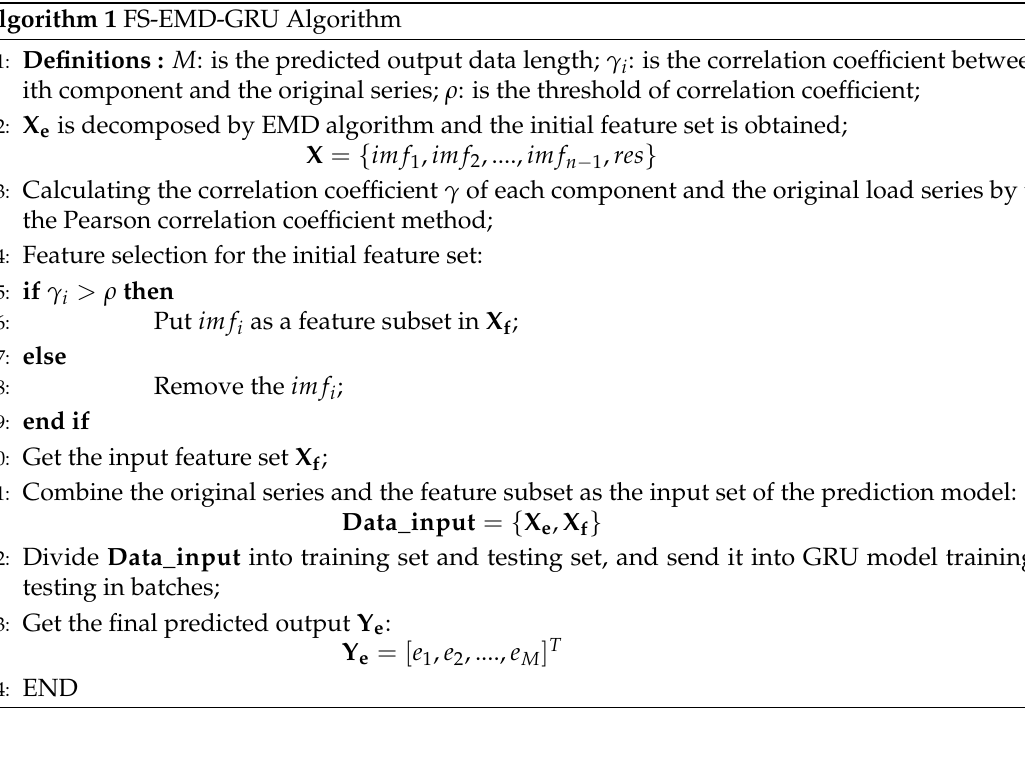
Algorithm 1 FS-EMD-GRU